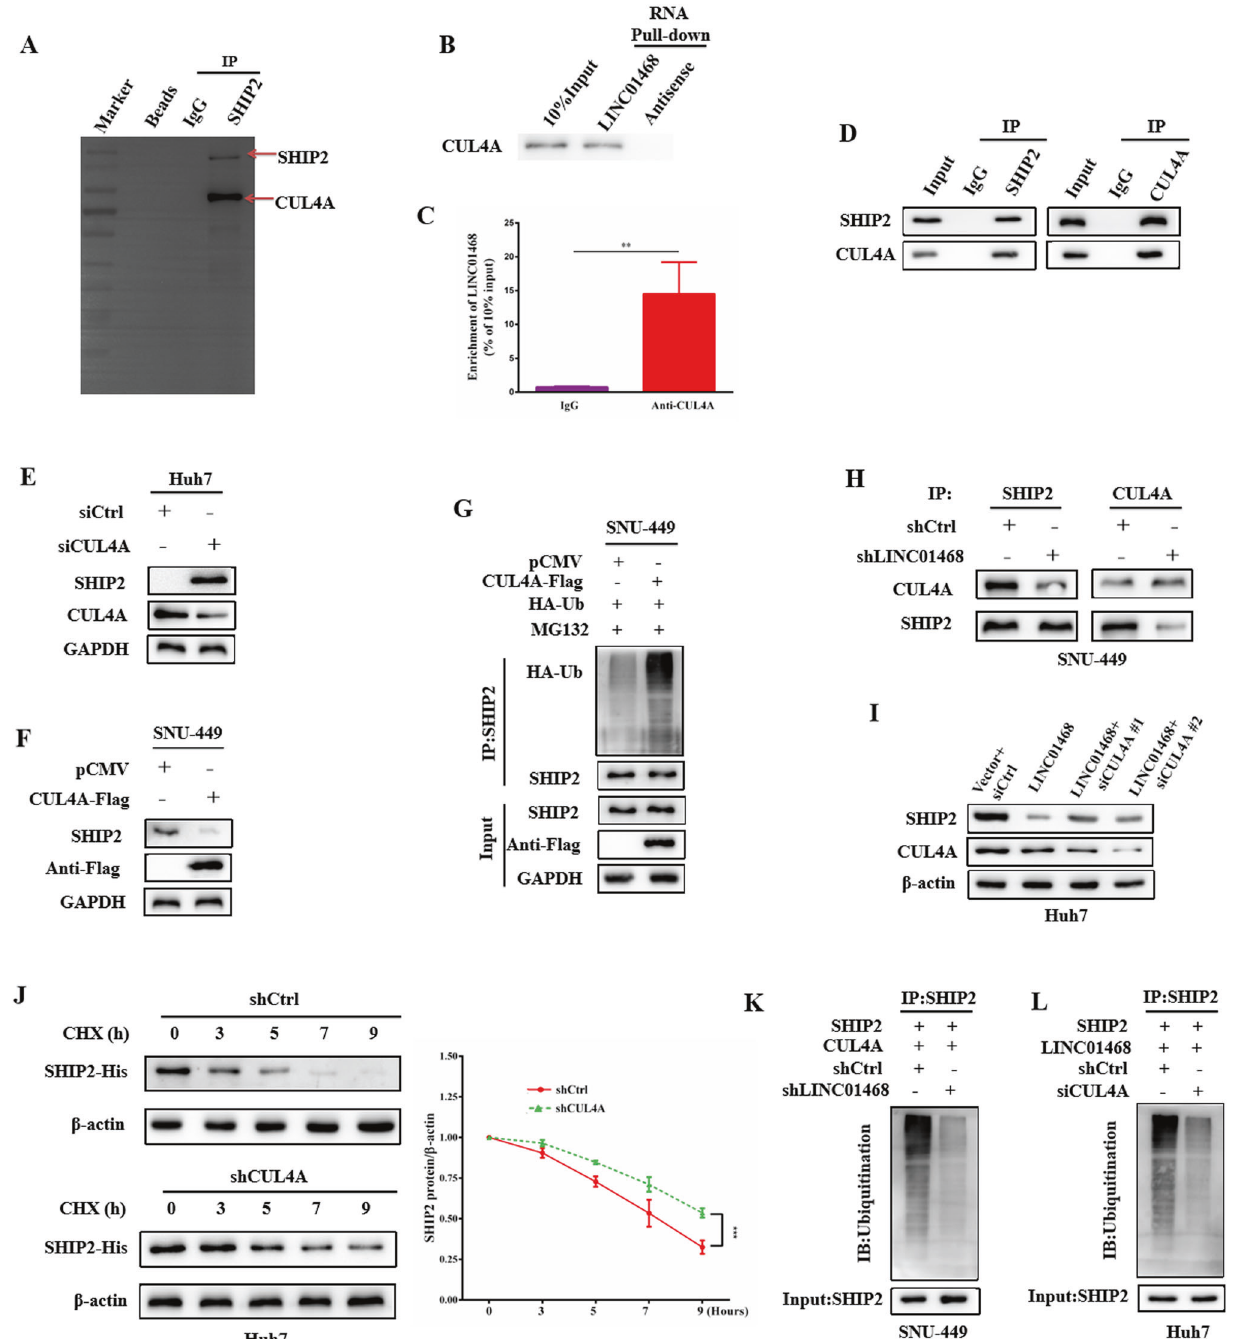
Fig. 6 LINC01468 enhances binding of E3 ubiquitin ligase CUL4A to SHIP2. A After immunoblot analysis,the gel were stained with coomassie brilliant blue and the bands that were precipitated speci fi cally by SHIP2 underwent mass spectrometric detection. B The binding of LINC01468 to CUL4A was revealed by LINC01468 pull-down followed by immunoblot analysis. C RIP assay showed that LINC01468 binds to CUL4A. The data represent the means ± S.D (** P < 0.01). D Co-IP showed the binding of SHIP2 to CUL4A. E Huh7 cells transfected with siCUL4A or F SNU-449 cells transfected with CUL4A-Flag plasmid were submitted to examine SHIP2 and CUL4A by western blotting. G CUL4A promotes SHIP2 ubiquitination. SNU-449 cells transfected with or without CUL4A-Flag plasmid were treated with MG132 (5 μ M for 4 h), after which cells were subjected to Co-IP with SHIP2. H LINC01468 silencing decreased the interaction of SHIP2 with CUL4A. I Knockdown of CUL4A abrogated the LINC01468-mediated degradation of SHIP2 protein. J Silencing of CUL4A prolonged the degradation of SHIP2. Immunoblotting detection of His tag is shown. K Knockdown of LINC01468 reduced the ubiquitination of SHIP2. L Knockdown of CUL4A reduced the ubiquitination of SHIP2. The input of the cell lysates were showed in the bottom panels.